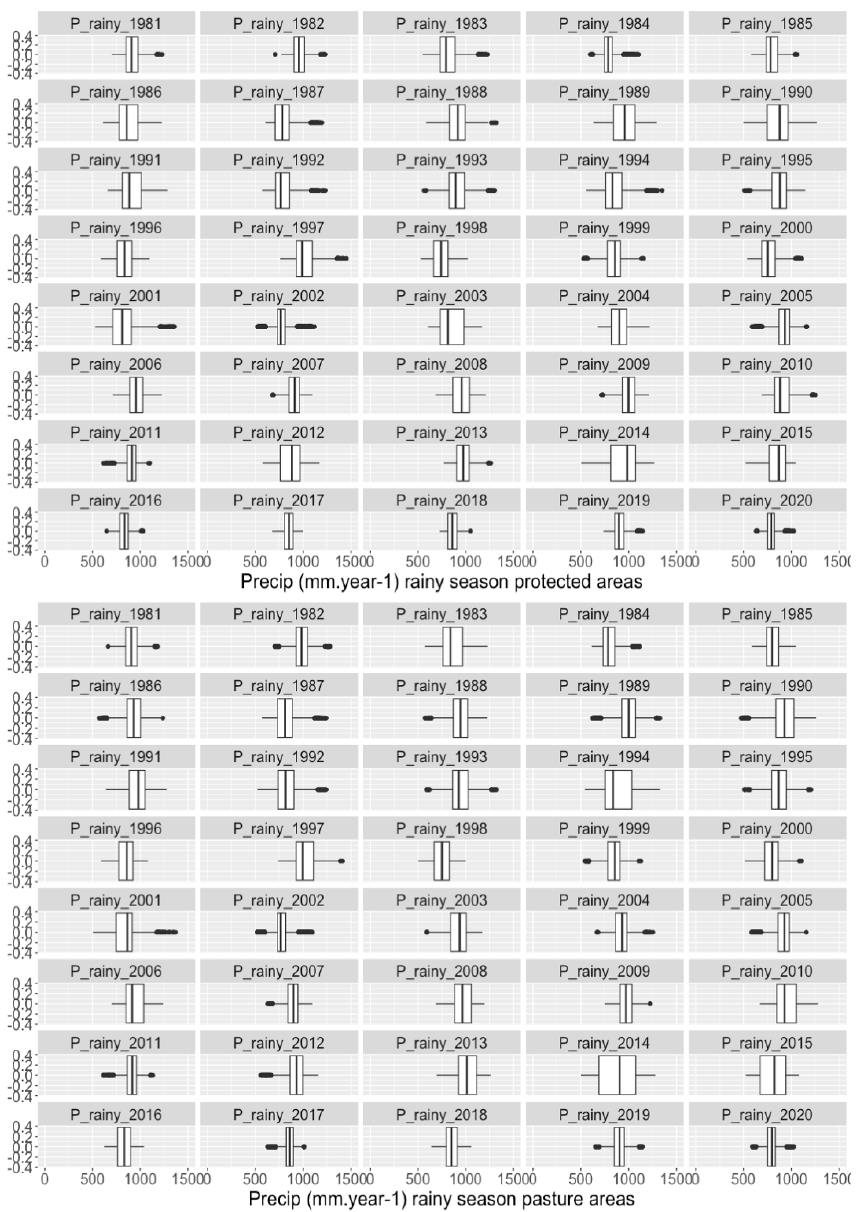
Figure 8. Yearly accumulated rainfall for the rainy season in Rondônia for the years 1981 to 2020 using CHIRPS data. These are the mean values of all valid pixels of CHIRPS images for protected and pasture areas.